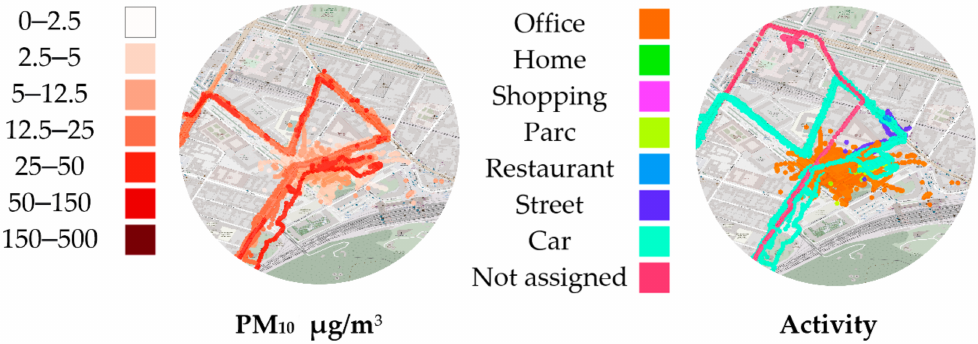
Figure 7. Geographical point of interest A for particulate matter (PM 10 ) measurements “Workplace” cluster surrounded of other activities.